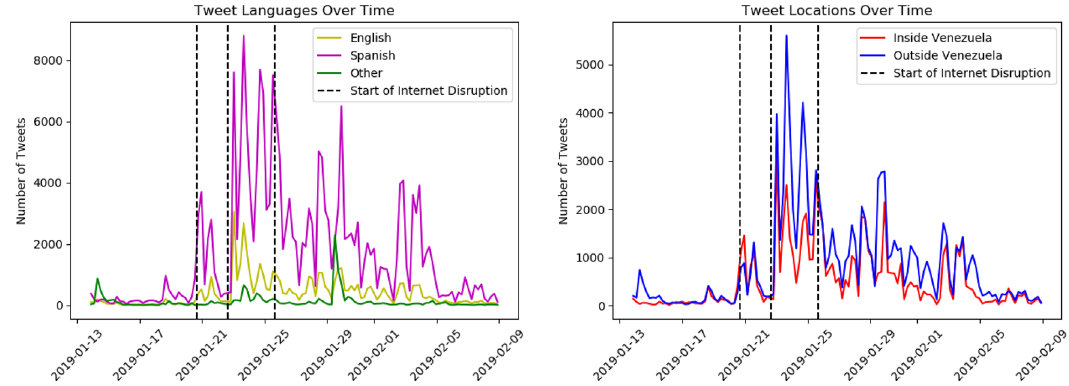
Figure 1. A breakdown of tweet counts by language (left) and user location (right) that we have collected using our Twitter query, with the three internet outage events marked by vertical dashed